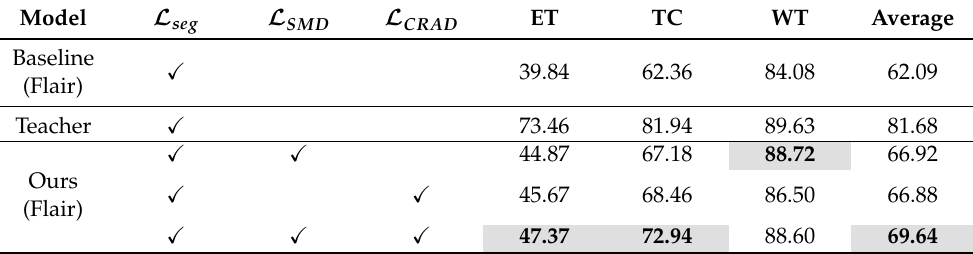
Table 3. Contribution of each module in the unimodal (Flair) scenario